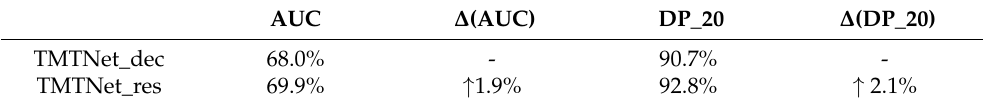
Table 6. The AUC score and DP_20 value of the TMTNet_res tracker and TMTNet_dec tracker. AUC ∆ (AUC)